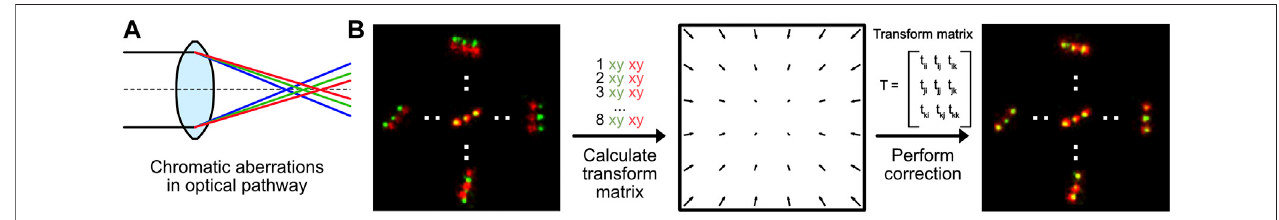
FIGURE 5 | Chromatic aberration correction. (A) Optical elements in any microscope will refract light of different wavelengths differently, causing chromatic aberrations. (B) Chromatic aberrationscanbecorrectedbycalculatingatransformation matrixbasedonpairwisepositionsof fl uorescentmarkersmeasured atdifferent wavelengths. This transformation can be used to correct the instrument-speci fi c chromatic